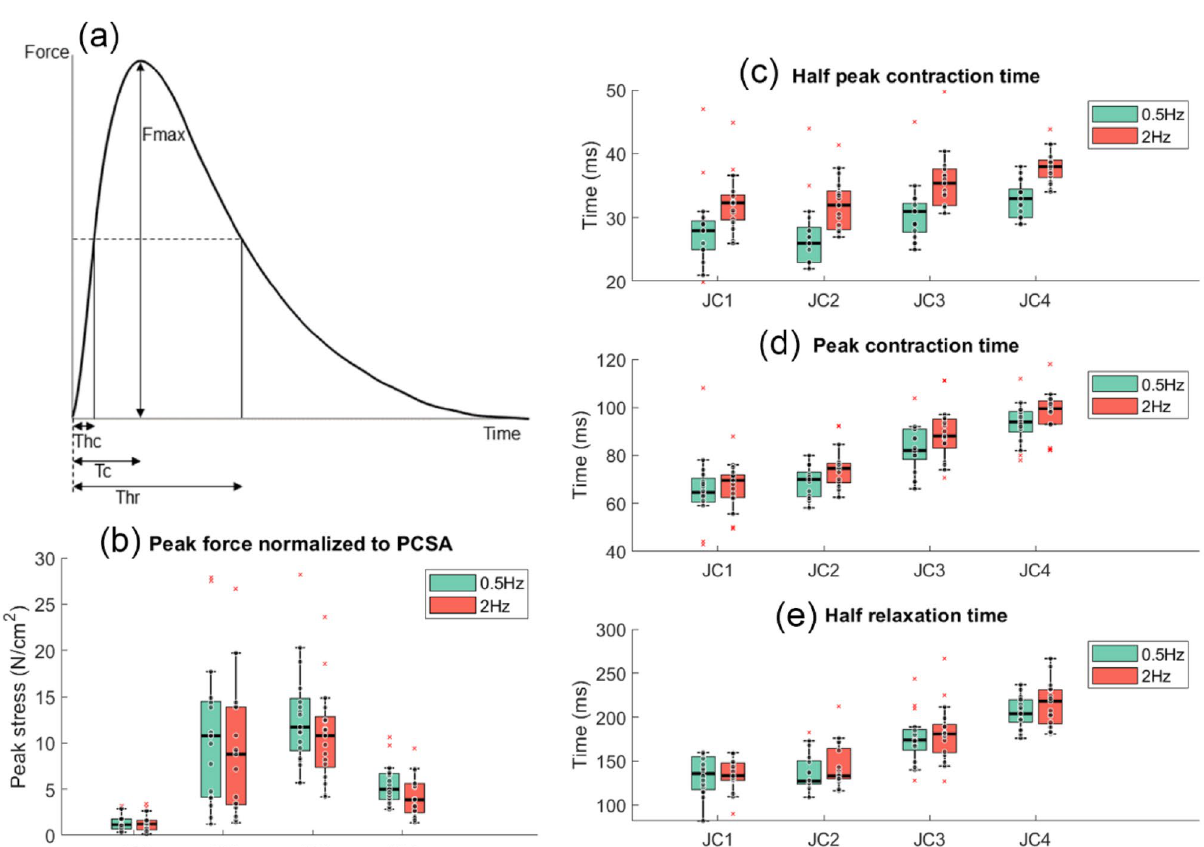
Figure 16. Muscle contractile parameters for 0.5 Hz and 2 Hz activation. ( a ) Definition of the twitch contractile parameters; Thc time from start of contraction to moment when force is half its maximum value, Tc time from start of contraction to moment when force is at its maximum value, Thr time from start of contraction to when force decreases to half its maximum value during the relaxation phase, Fmax maximum twitch force. ( b ) Peak force normalized to muscle physiological cross-sectional area. ( c ) Half peak contraction time (Thc). ( d ) Peak contraction time (Tc). ( e ) Half relaxation time (Thr). Twitch parameters for 0.5 Hz are compared to the first 2 Hz contraction for seventeen subjects (n =